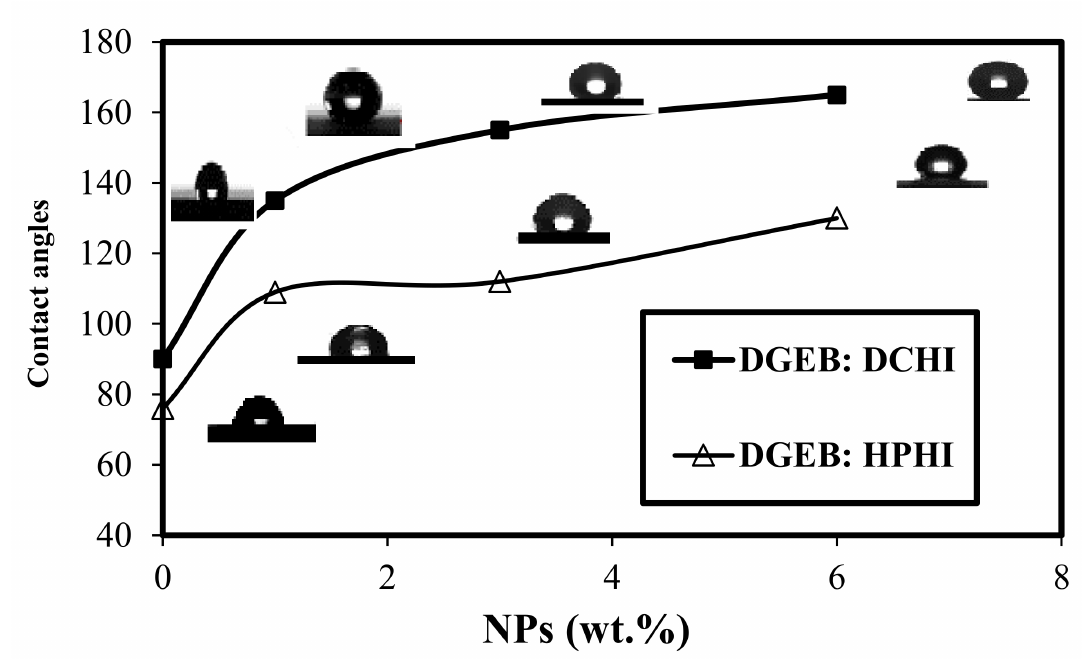
Figure 13. Seawater contact angle (WCA) measurements of coated steel panels with DGEB / DCHI or DGEB / HPHI in the absence and presence of their magnetite NPs at 25 ◦